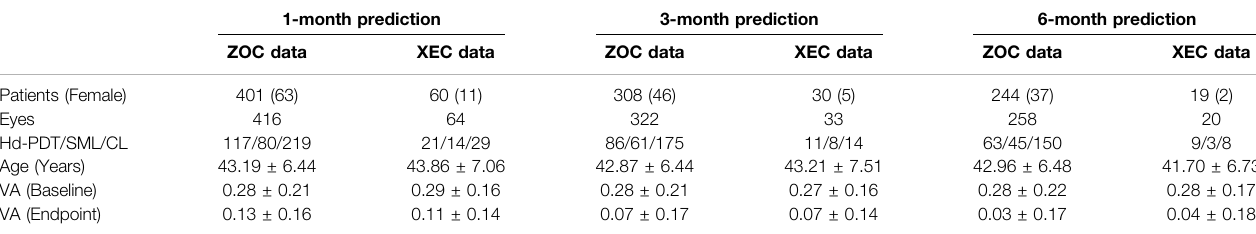
TABLE 1 | Patient demographics.